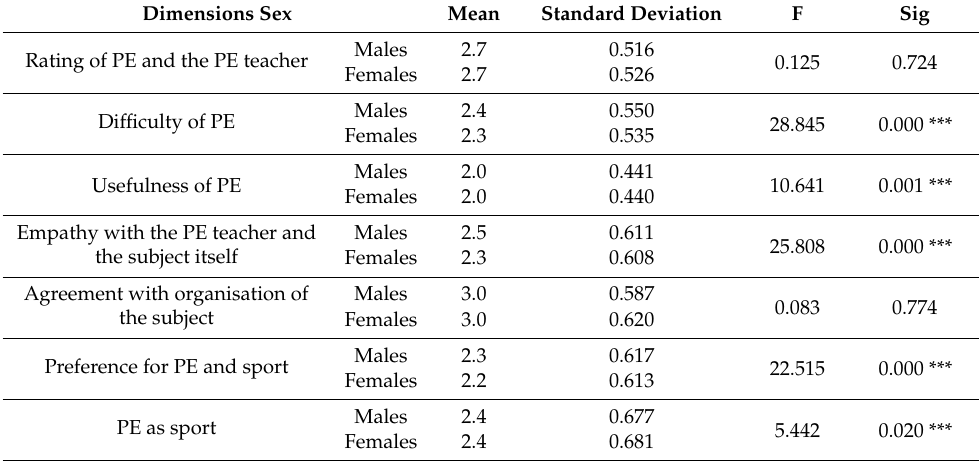
Table 2. Relation between attitudes towards physical education and